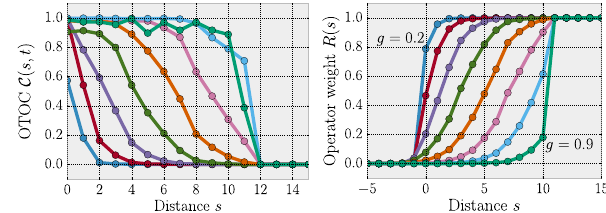
FIG. 6. OTOC (left panel) and operator weight R ð s Þ (right panel) for different distances s after t=T ¼ 12 driving cycles of the kicked Ising model with the strength of the transverse field g ¼ 0 . 2 ; 0 . 3 ; … ; 0 . 9 , as indicated in the right figure. The longi- tudinal field is fixed at h ¼ 0 . 809 , while the period time is T ¼ 1 . 6 . The butterfly velocity shows a strong dependence on the coupling g , with the front width increasing as one moves away from the limit of maximal